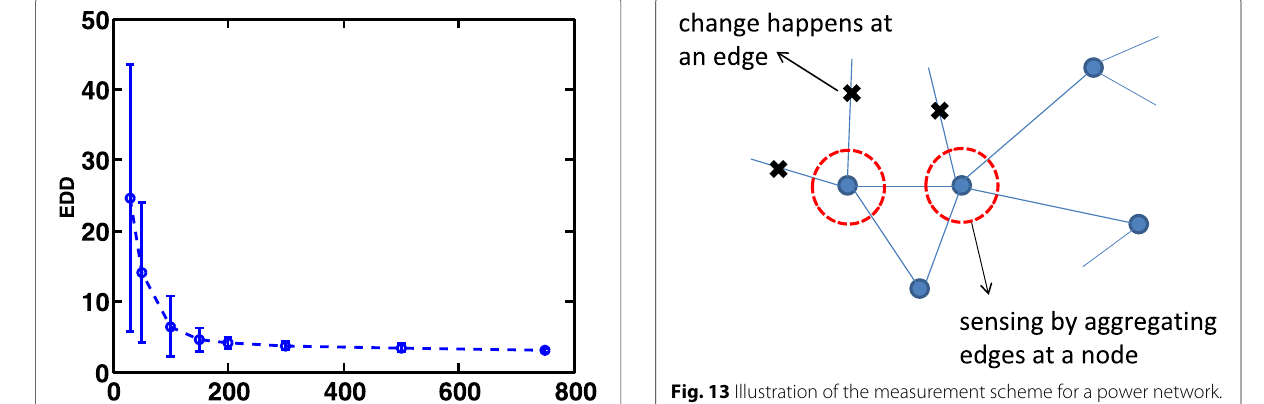
The sketching procedures were derived based on the generalized likelihood ratio statistic. We analyzed the theoretical performance of our procedures by deriving approximations to the average run length (ARL) when there is no change, and the expected detection delay (EDD) when there is a change. Our approximations were shown to be highly accurate numerically and were used to understand the effect of sketching.